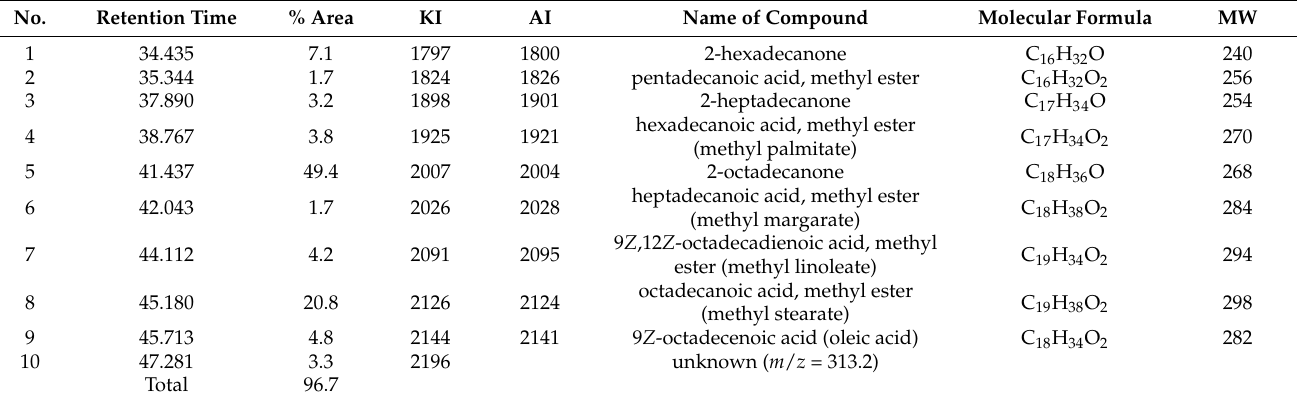
Table 6. Chemical composition of fraction AE.